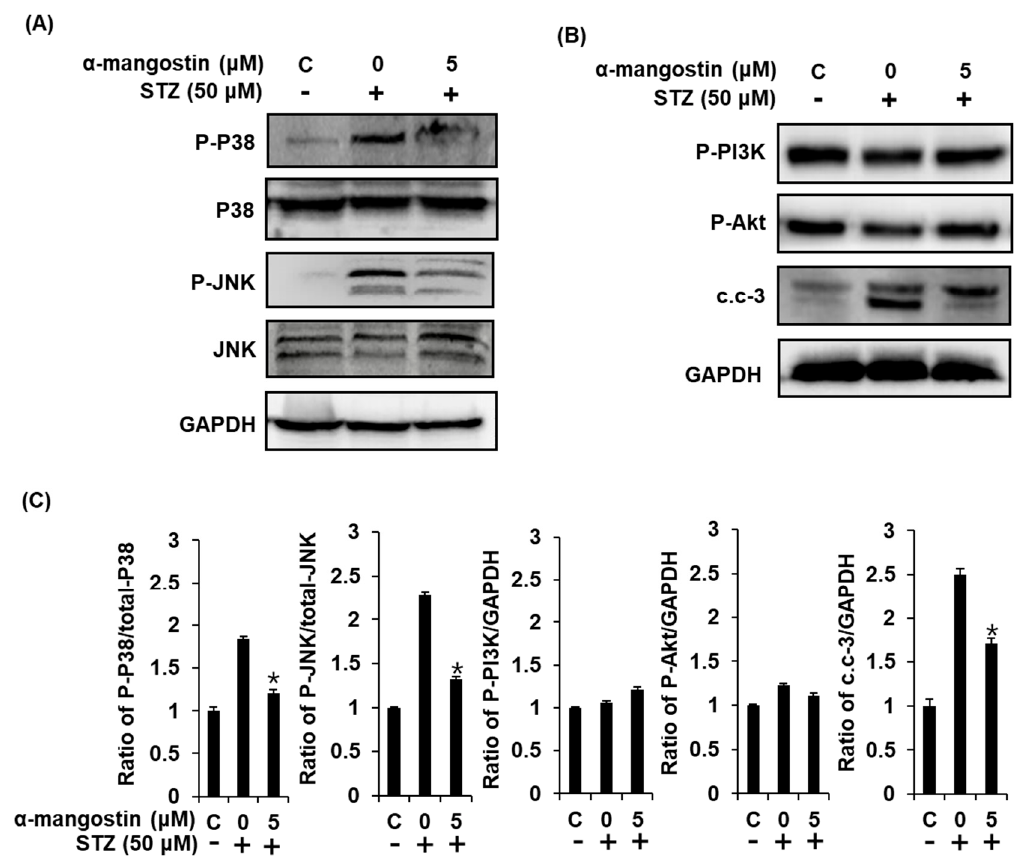
Figure 5. Effect of α -mangostin on MAPKs, PI3K/Akt, and cleaved caspase-3 (c.c-3) in INS-1 cells. ( A ) Protein expression levels of P-P38, P38, P-JNK, JNK, and GAPDH in INS-1 cells treated or untreated with STZ and 5 µ M α -mangostin for 24 h. ( B ) Protein expression levels of P-PI3K, P-Akt, cleaved caspase-3, and GAPDH in INS-1 cells treated or untreated with STZ and 5 µ M α -mangostin for 24 h. ( C ) Each bar graphs present the densitometric quantification results of Western blot bands. * p < 0.05 compared to the STZ-treated control value.